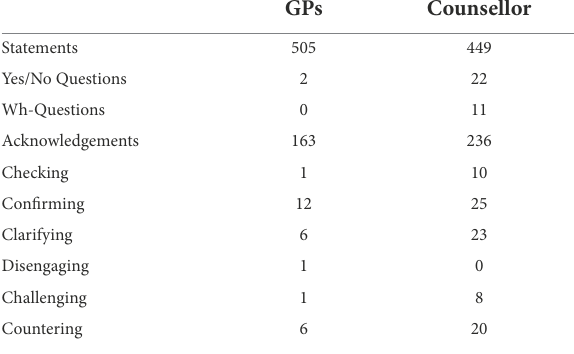
TABLE 2 Speech functions in GP–counsellor